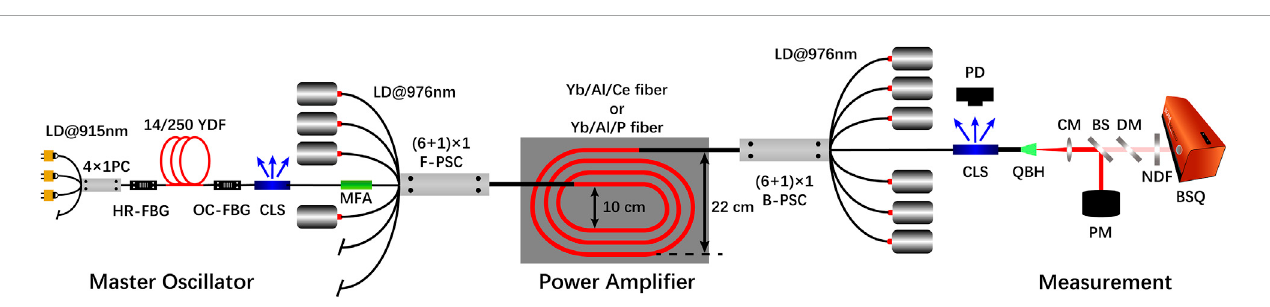
FIGURE 4 Schematic diagram of the experimental setup for PD loss measurement.